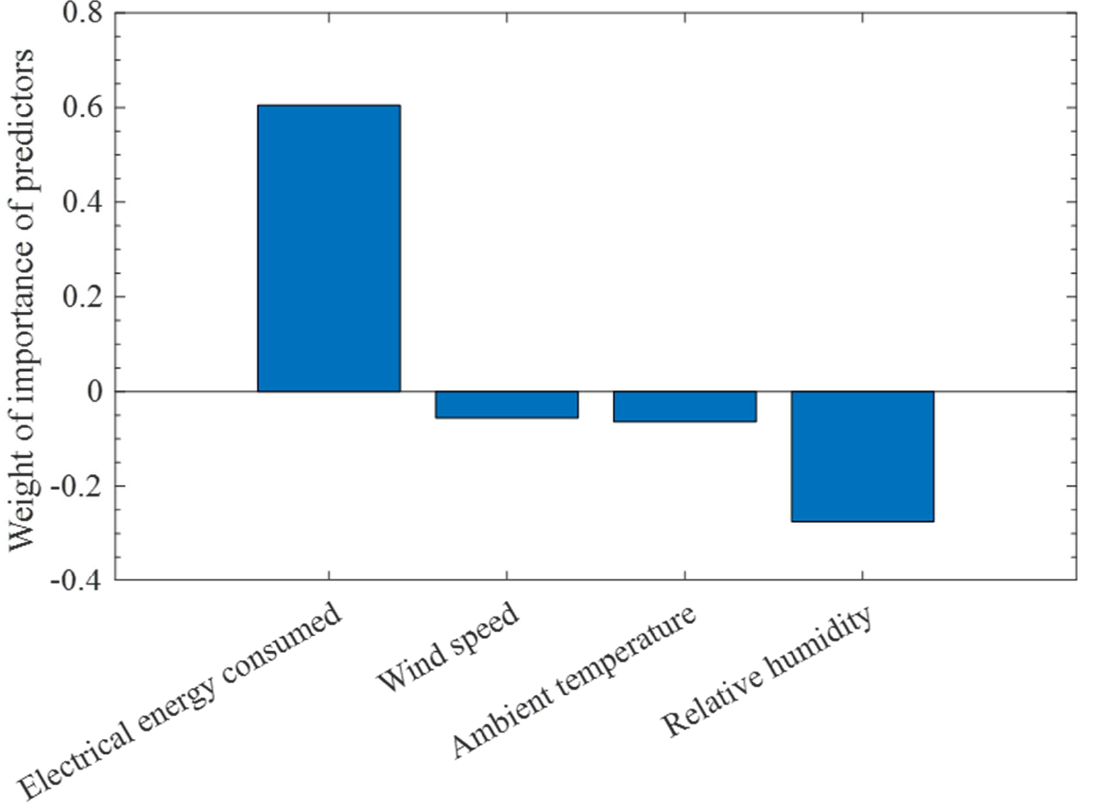
Figure 11. Ranking of predictors by weights of importance.